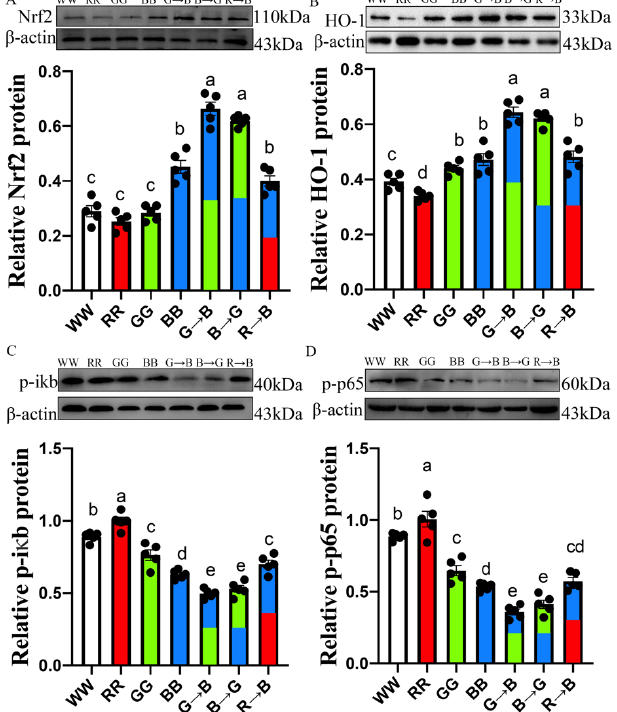
Figure 4. Nrf2 ( A ), HO ‐ 1 ( B ), p ‐ i κ b ( C ), p ‐ p65 ( D ) protein level in bursa at P42. The results of each group were expressed as the mean ± standard error. Differences between seven light treatment groups were evaluated by one ‐ way ANOVA, and values with no common letters differ significantly ( p < 0.05).